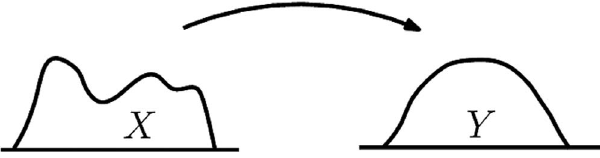
Fig. 6. Concept of the EMD between two probability